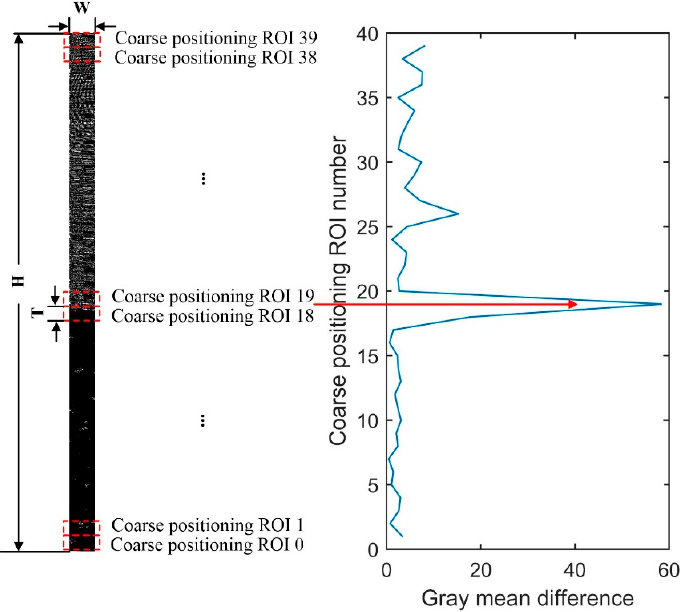
Figure 7. Schematic diagram of coarse positioning of water line.